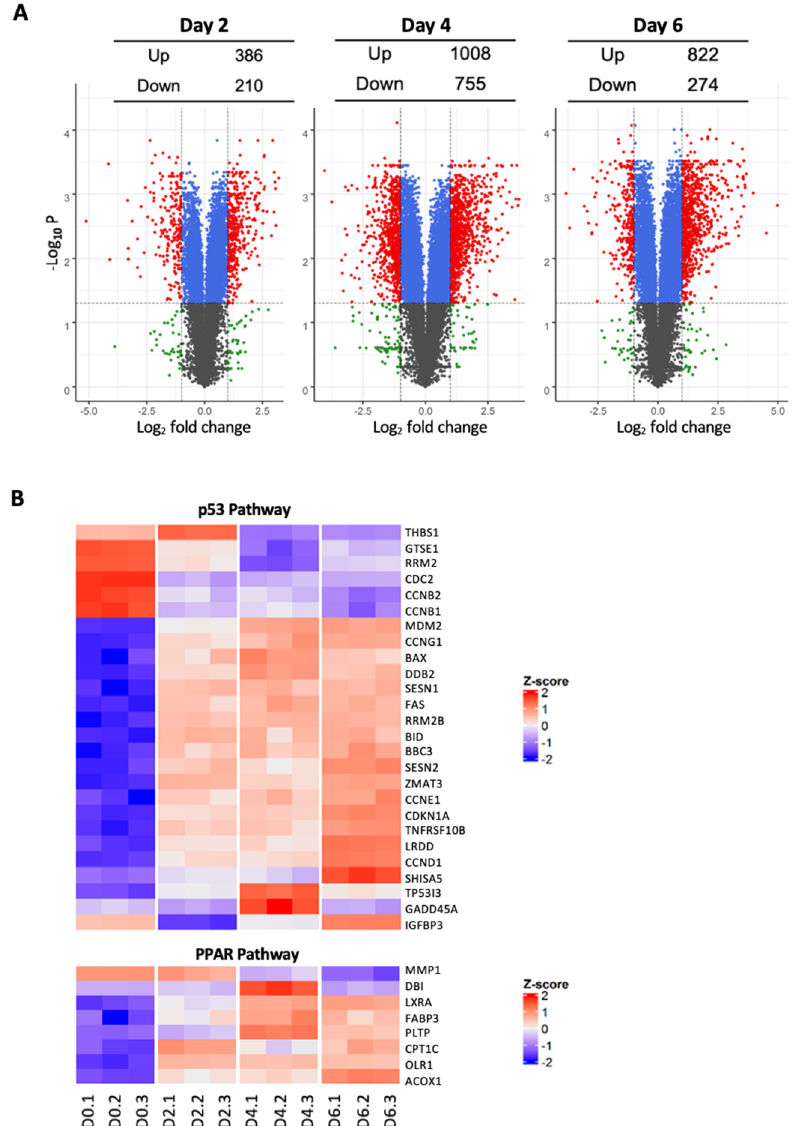
Figure 4. Inducible HPV16E6E7 knockdown alters the transcriptomic signature of HPV16+ SCC cells. ( A ) Volcano plot. Total RNA was extracted from UMSCC47-shRNA4 cells at day 0 and at days 2, 4, and 6 after doxycycline induction using TRIZol and processed for RNA-Seq. Transcriptomic and KEGG pathway analyses were performed with the GAGE package in R. ( B ) Heat map of representative genes in the p53 and PPAR pathways.